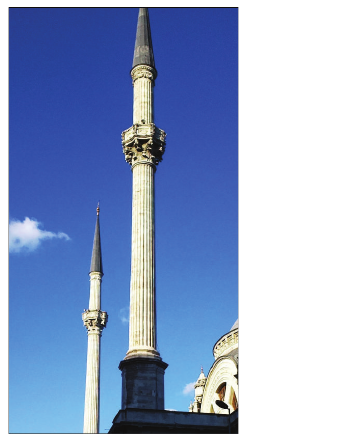
Figure 1: View of Dolmabahce Mosque minarets (taken by author).